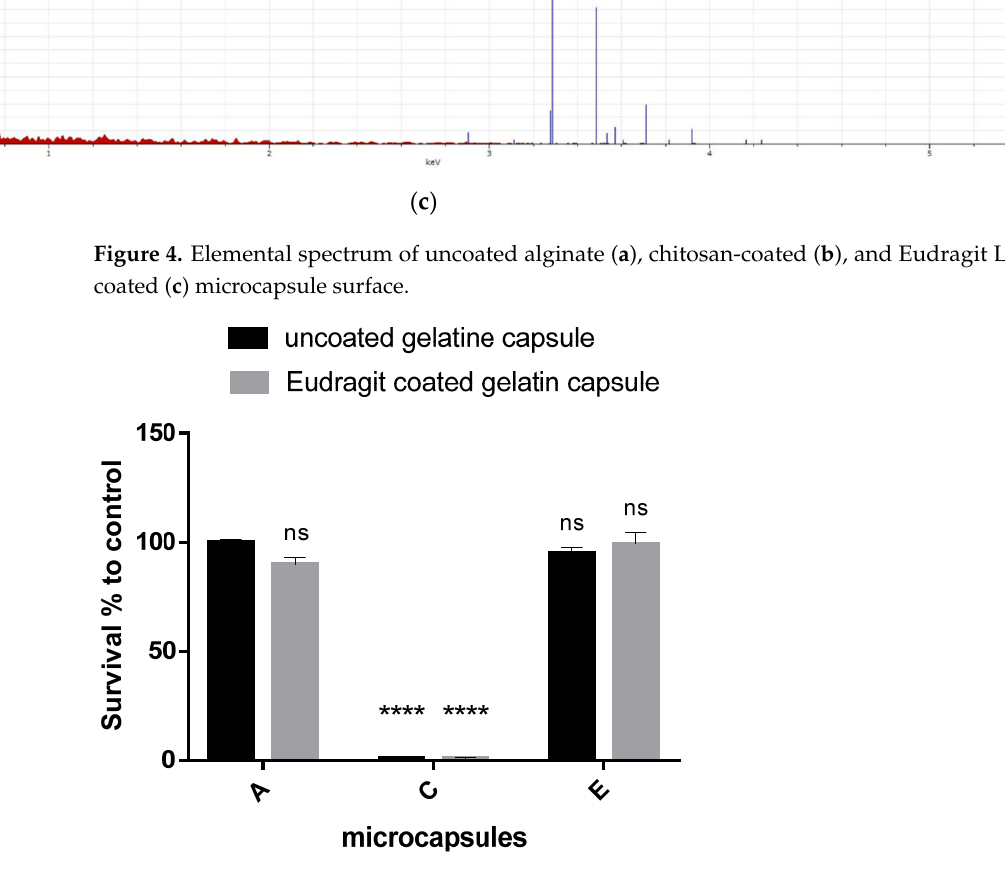
Figure 5. Survival compared to control (alginate uncoated microcapsules filled in uncoated gelatin capsule) of uncoated alginate (A), chitosan-coated (C), and Eudragit-coated (E) microcapsules filled in uncoated gelatin and Eudragit-coated gelatin capsule. Data are presented as means ± SDs, n = 3. Differences were considered significant at p < 0.05; **** p < 0.0001, and ns means not significant.